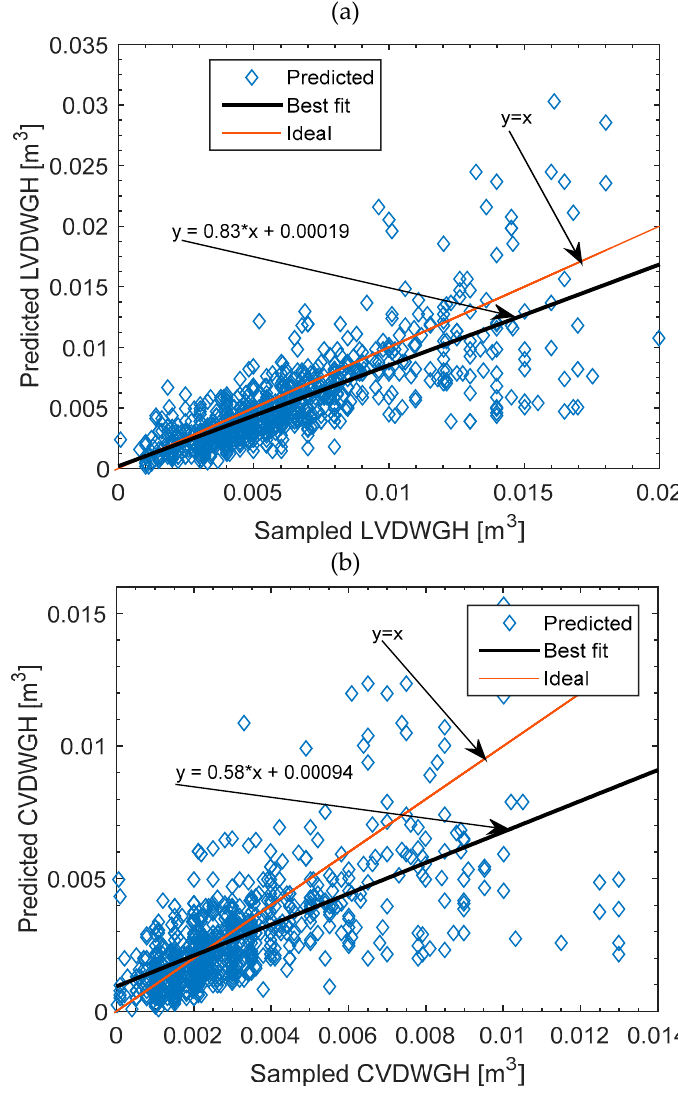
Figure 5. The graphical depiction of results of volume analysis. ( a ) loose volume and ( b ) compact volume. LVDWGH and CVDWGH means Loose Volume or Compact Volume of Daily Waste Generated from